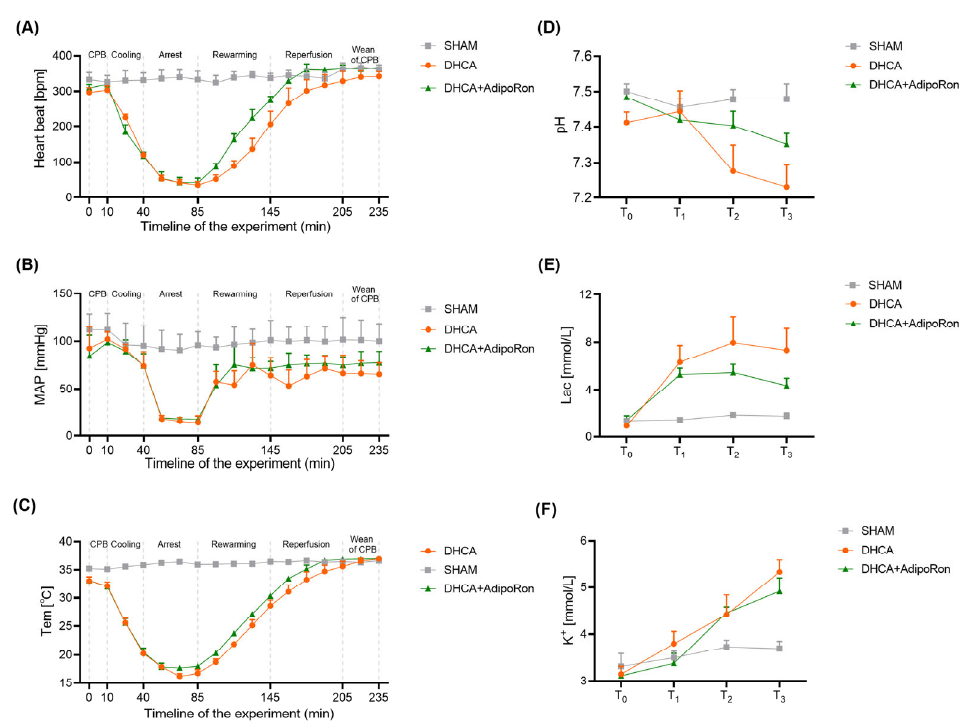
Figure 3. Impact of AdipoRon on cardiocirculatory recovery and blood gas results after DHCA in rats. Heart rate ( A ), mean arterial blood pressure ( B ), and temperature ( C ) were monitored throughout the entire procedure. Blood gas analysis was performed at predefined time-points for both groups. pH ( D ), plasma concentration of lactic acid ( E ) and potassium ( F ) were measured and compared. Rats in the sham group were only anesthetized, cannulated and heparinized. The time points shown in the sham group are relative and no DHCA procedures have been performed. Vital signs and the results of the blood gas analysis are shown as real values (n = 6). Data are presented as the mean ± standard error of median (SEM). Student’s t test was used to compare the differences between the DHCA group and the AdipoRon-treated DHCA group at each time point. MAP: mean arterial blood pressure; Tem: temperature; Lac: lactic acid; DHCA: deep hypothermia circulatory arrest